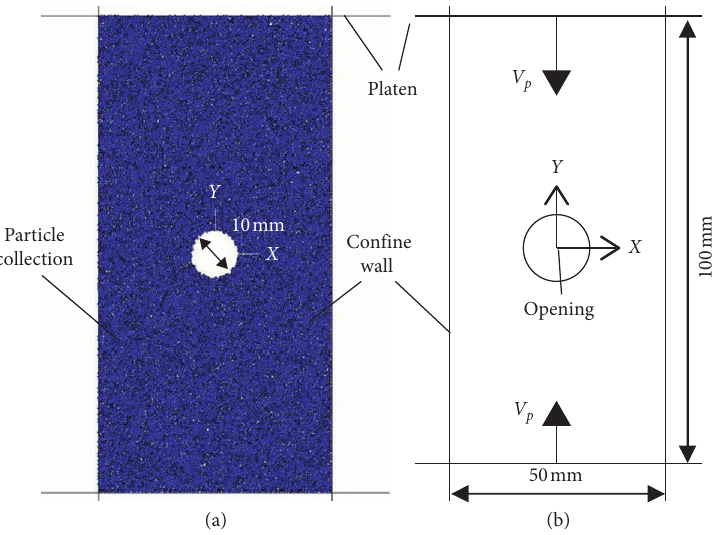
Figure 7: (a) The numerical model and (b) the loading